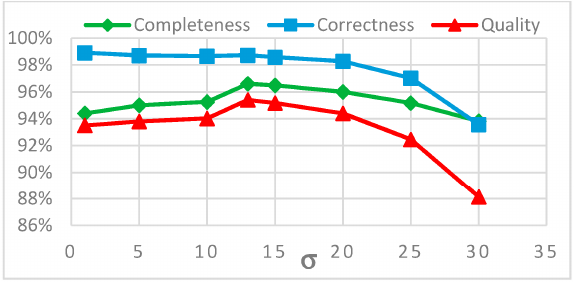
Figure 11. Analysis of impact of tensor voting scale ( σ ) on efficiency of the road extraction.